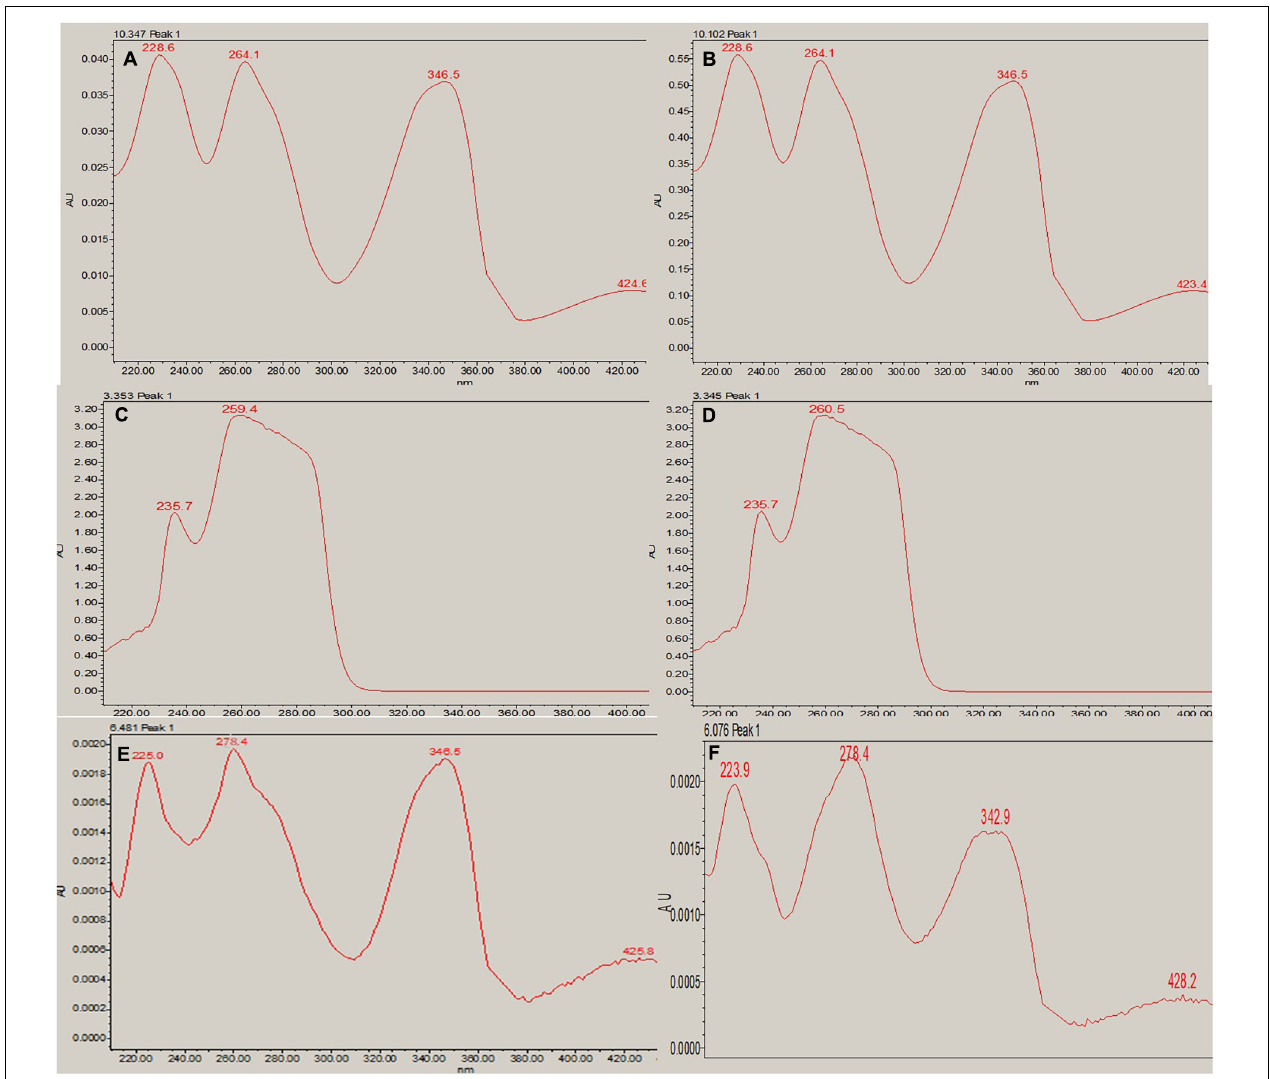
FIGURE 6 | RP-HPLC absorption maxima. (A) Berberine standard at a given wavelength of 346.5 nm (RT-10.347). (B) Berberine in the 100 nM BRD4770-treated crude metabolite at a given wavelength of 346.5 nm (RT-10.102). (C) Caffeine standard at a given wavelength of 259.4 nm (RT-3.353). (D) Caffeine in 100